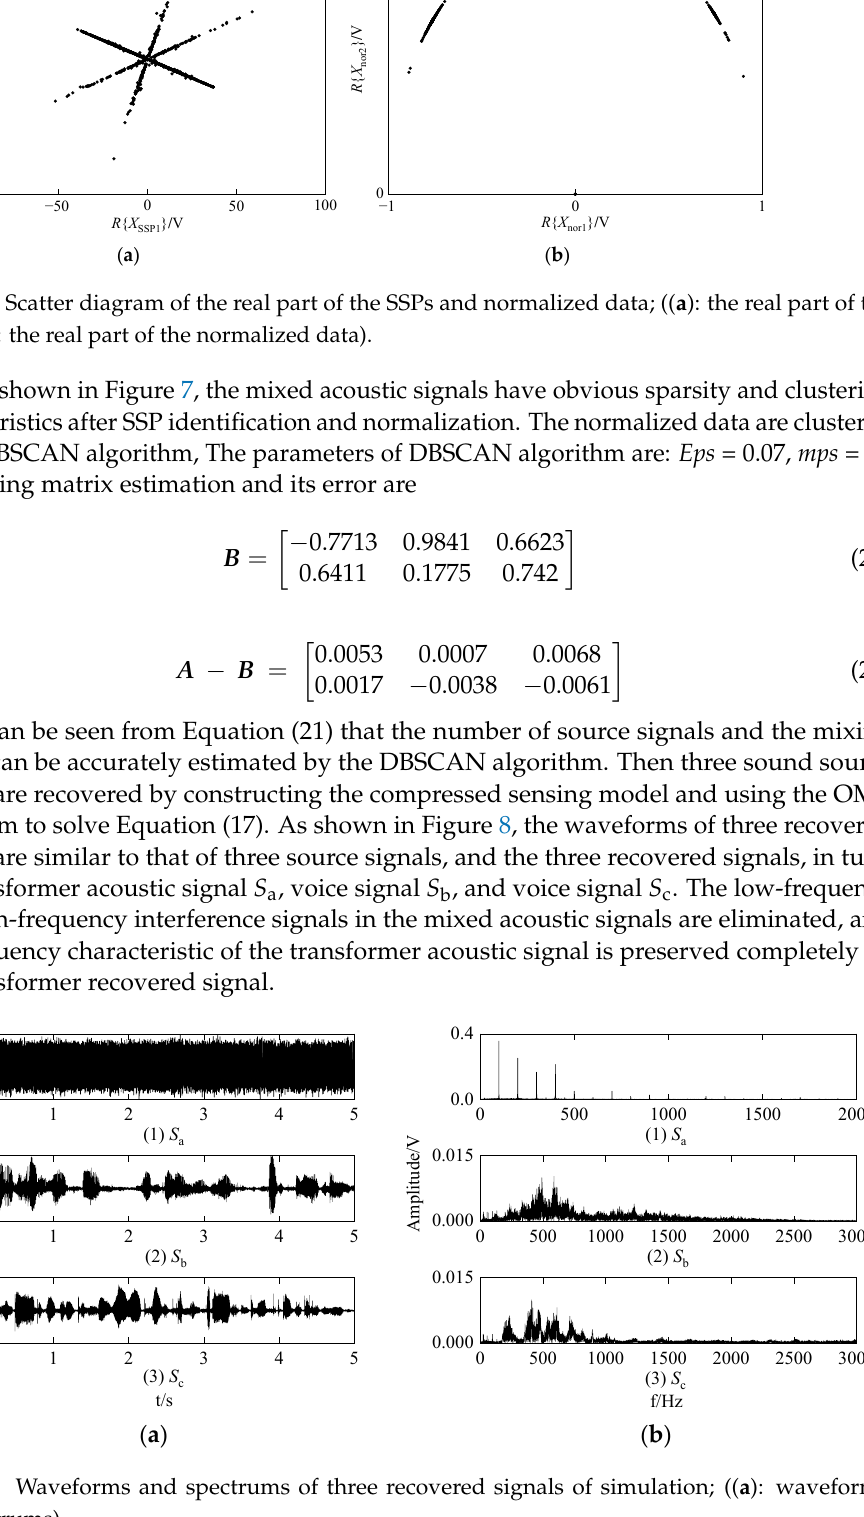
Figure 8. Waveforms and spectrums of three recovered signals of simulation; (( a ): waveforms; ( b ): spectrums.).